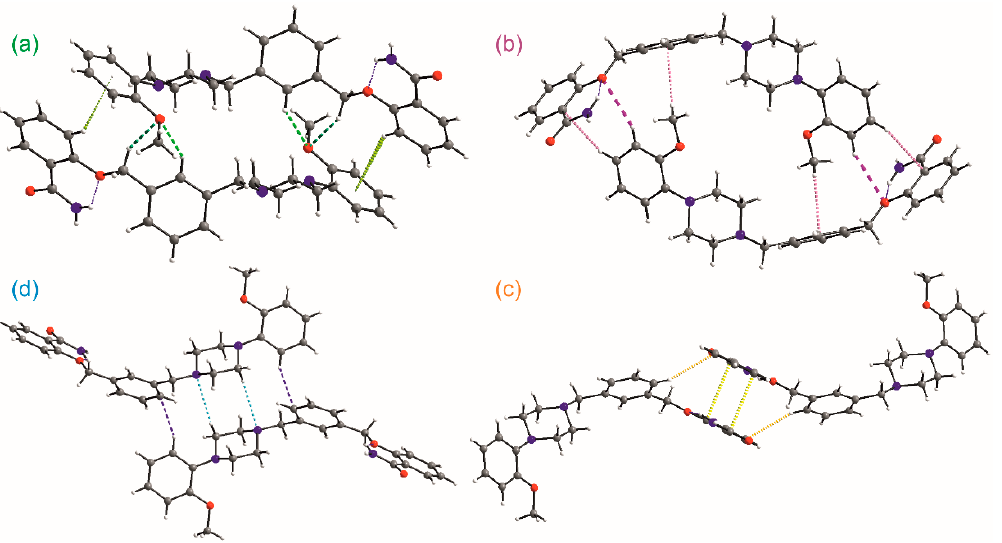
Figure 7. Main motifs formed by weak intermolecular interactions ( a – d ).